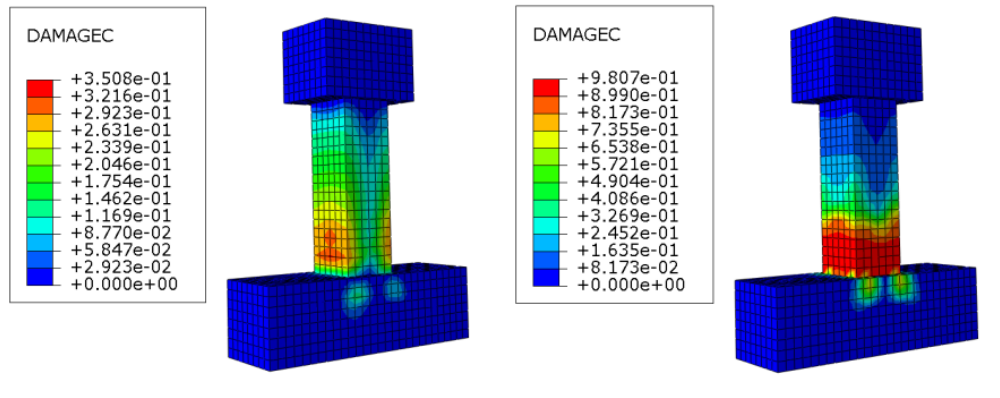
Figure 7: Nephograms of Compression Damage of